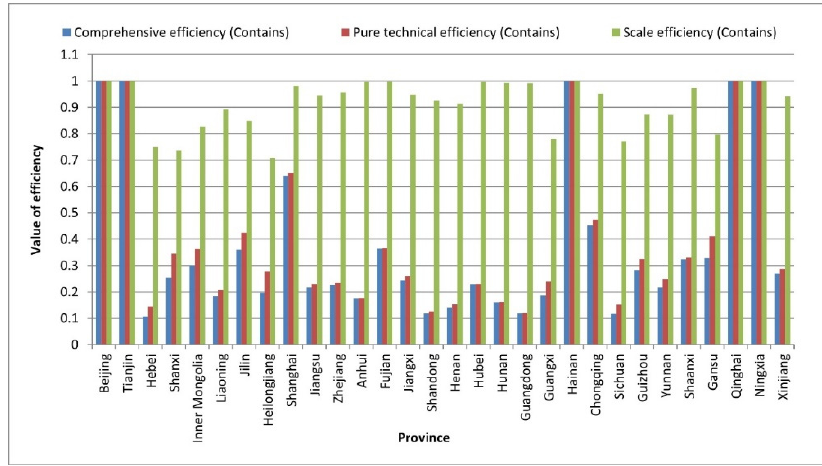
Figure 5. Efficiency values of quantity index.